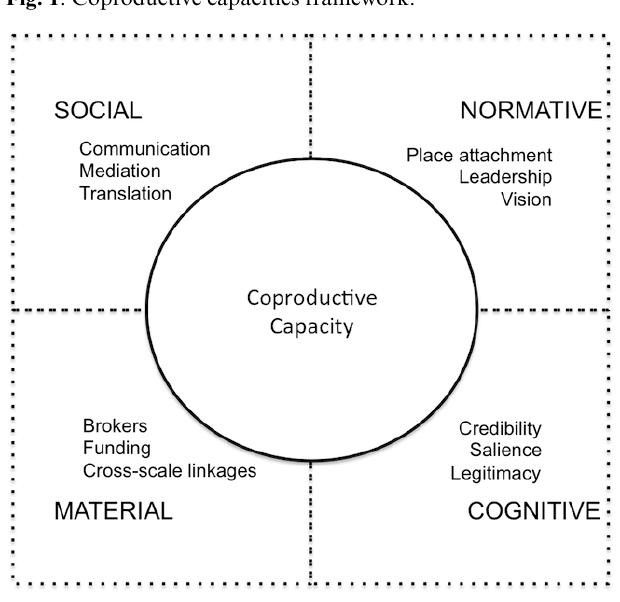
Fig. 1 . Coproductive capacities